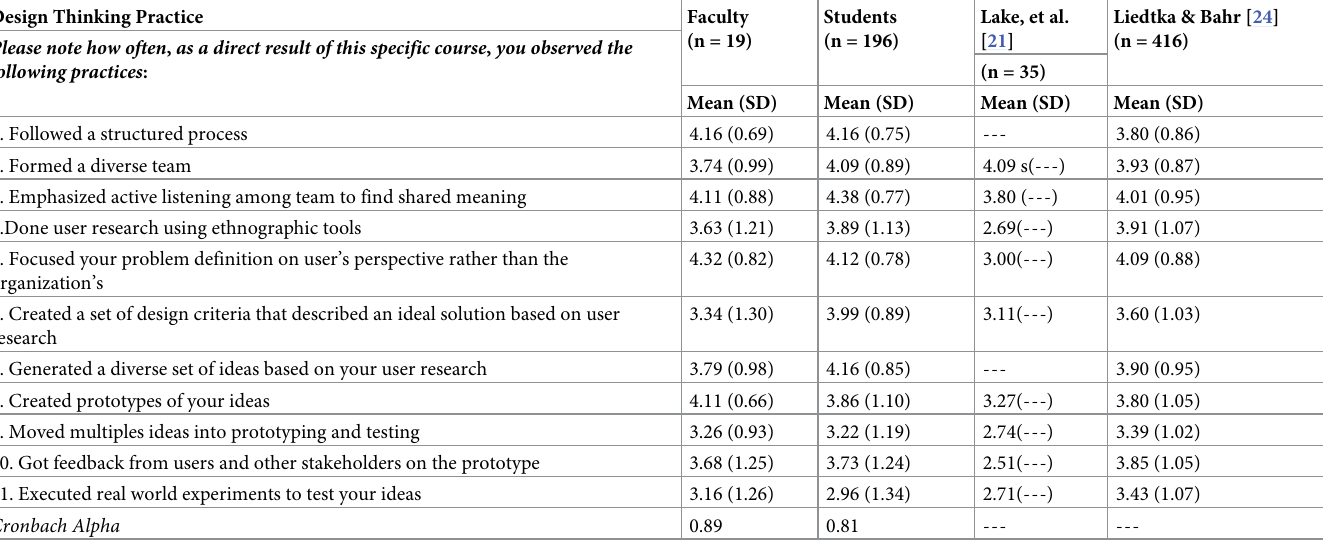
Table 2. Survey responses for DT practices in current study (faculty, students) and in Lake et al. [21] and Liedtka and Bahr [24]. Design Thinking